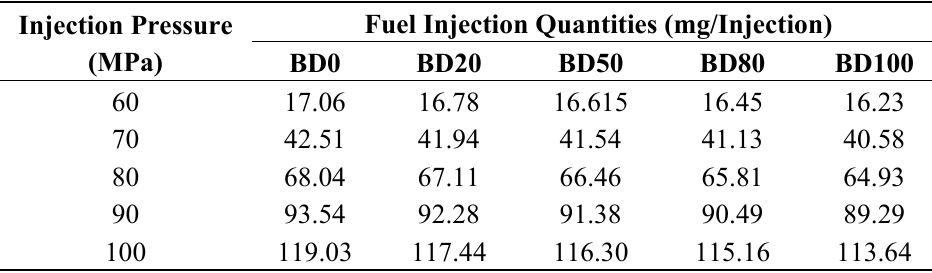
Table 3. The fuel injection quantities for each injection